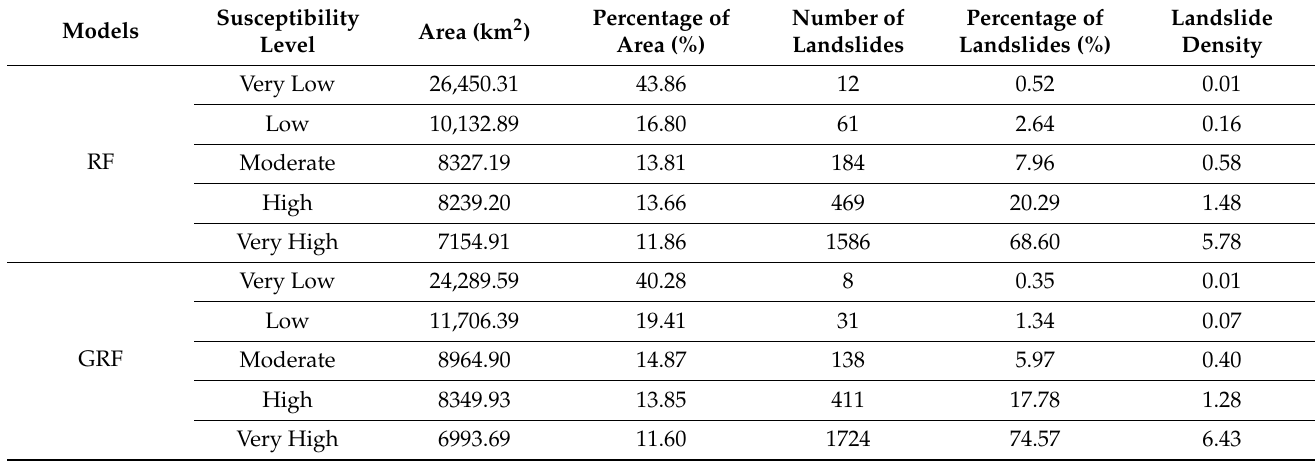
Table 6. Evaluation results of landslide susceptibility